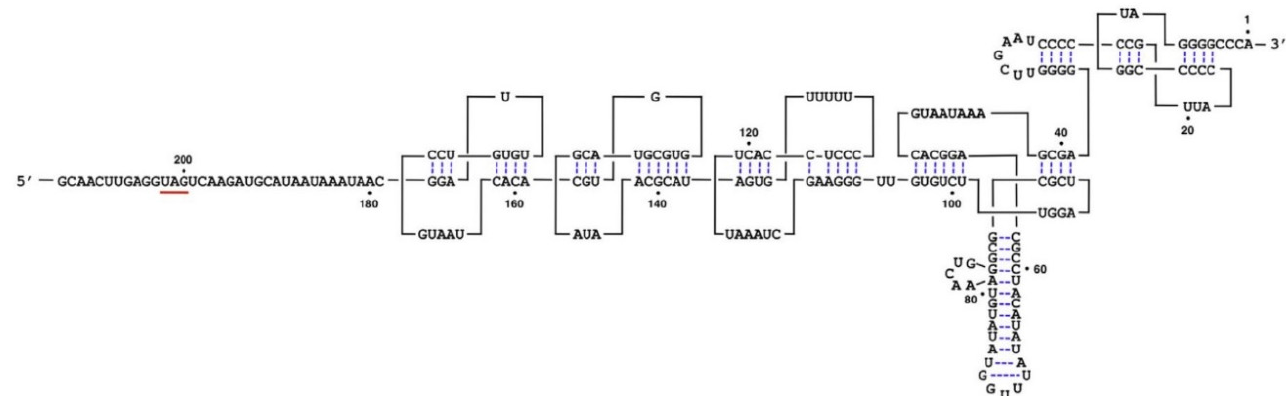
Figure 4. Schematic diagram of 3’-UTR of TMV RNA. Translational stop codon is underlined and nt numbers from the 3’ region are indicated. Image source [22].